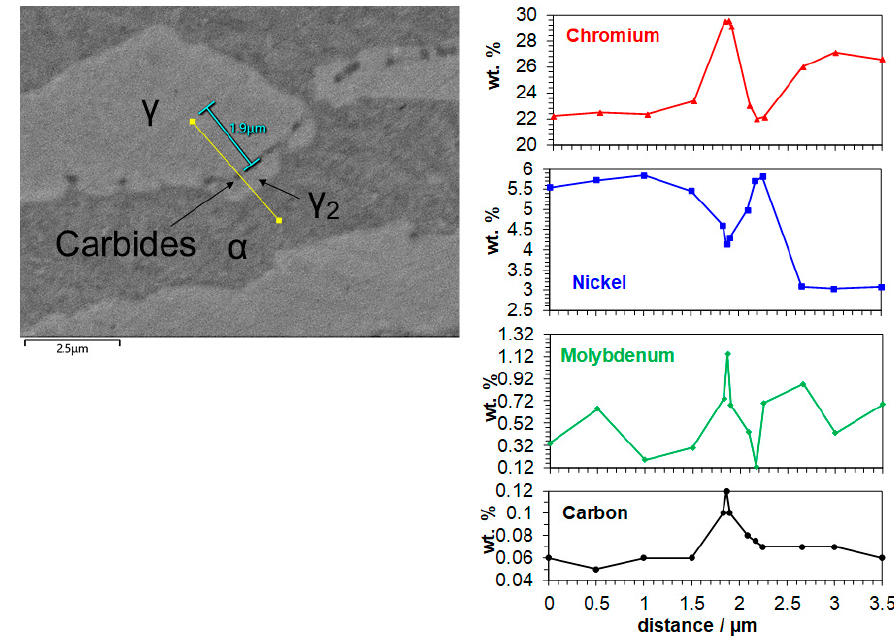
Figure 2. SEM-BSD image of DSS 2304 sample aged for 60 min at 750 °C. Quantitative profile line analysis of: chromium ( red ), nickel ( blue ), molybdenum ( green ) and carbon ( black ).